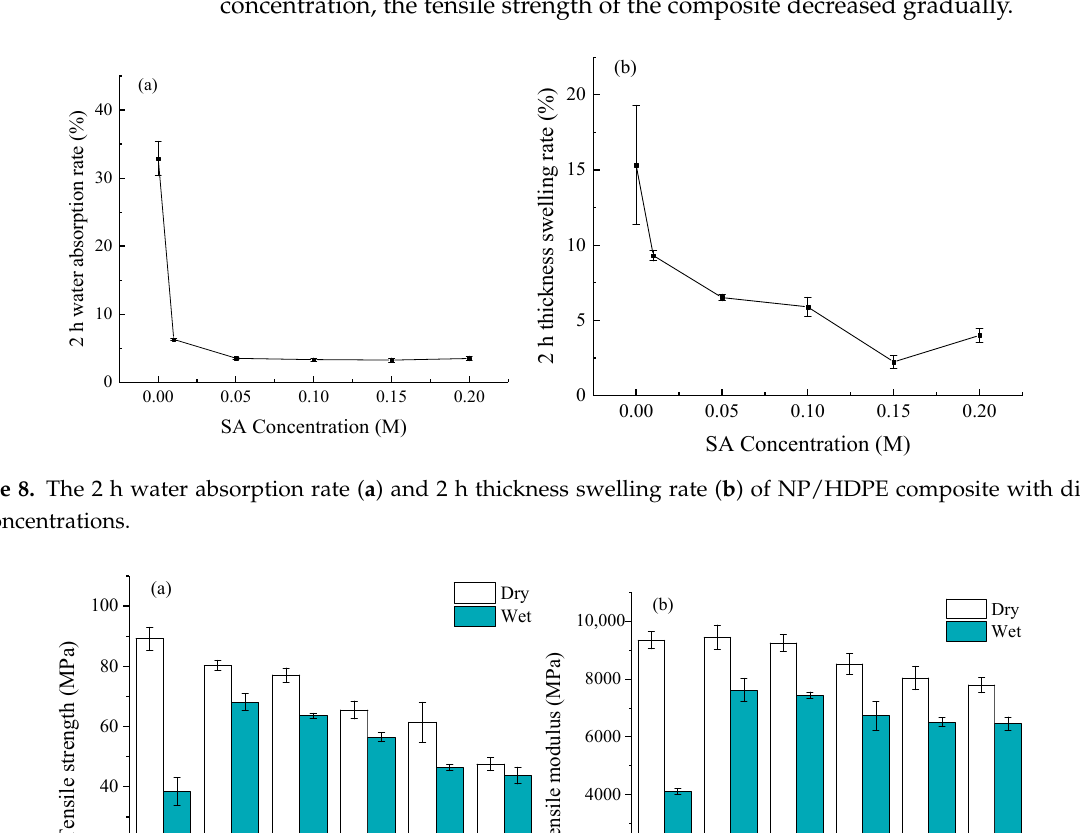
Figure 8. The 2 h water absorption rate ( a ) and 2 h thickness swelling rate ( b ) of NP/HDPE compo- site with different SA concentrations.